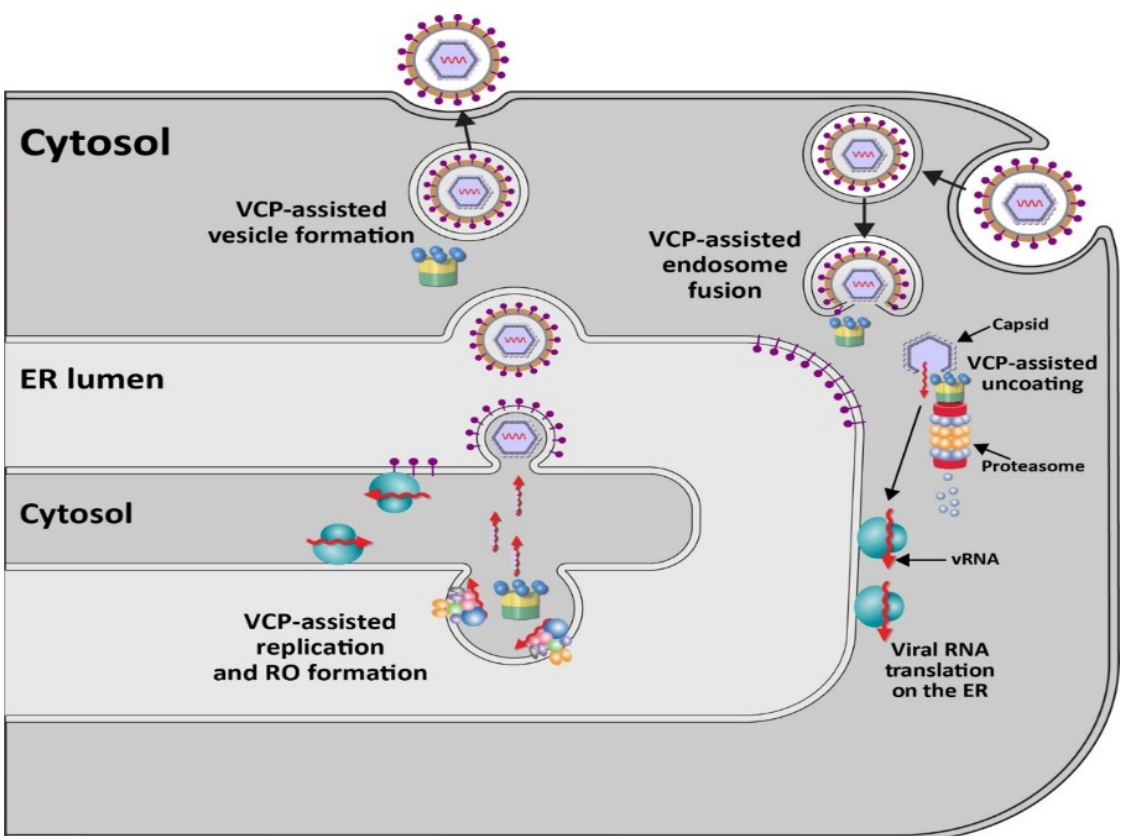
Figure 2. Role of VCP/p97 in the replication cycle of RNA-containing viruses. Since many RNA-containing viruses do not need the nucleus for their infectious cycles, this figure shows only a small portion of the cytoplasm, including an enlarged segment of the endoplasmic reticulum with a replication organelle (RO). Ribosomes are shown in blue, whereas viral RNAs are shown as red arrows. Viral nonstructural proteins are shown spanning the ER membrane in the RO. VCP is depicted as in Figure 1. Roles for VCP in flaviviral replication events have been documented for endosome fusion, RNA genome uncoating, and RO formation, although p97 participation in virion egress is not well documented. Other RNA-containing viruses have additional roles for p97 during viral replication. See text for details.